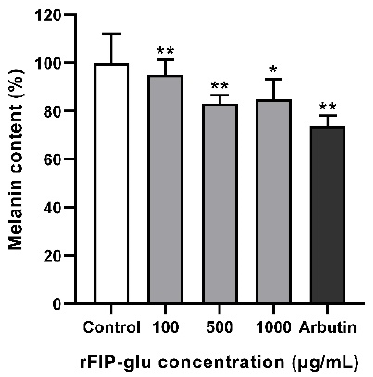
Figure 5. E ff ect of rFIP ‐ glu on the melanin content of B16 cells. Arbutin (100 µg/mL) was used as the positive control. Data are expressed as means ± SD (n = 3). *, p ≤ 0.05; **, p ≤ 0.01 versus the control group.